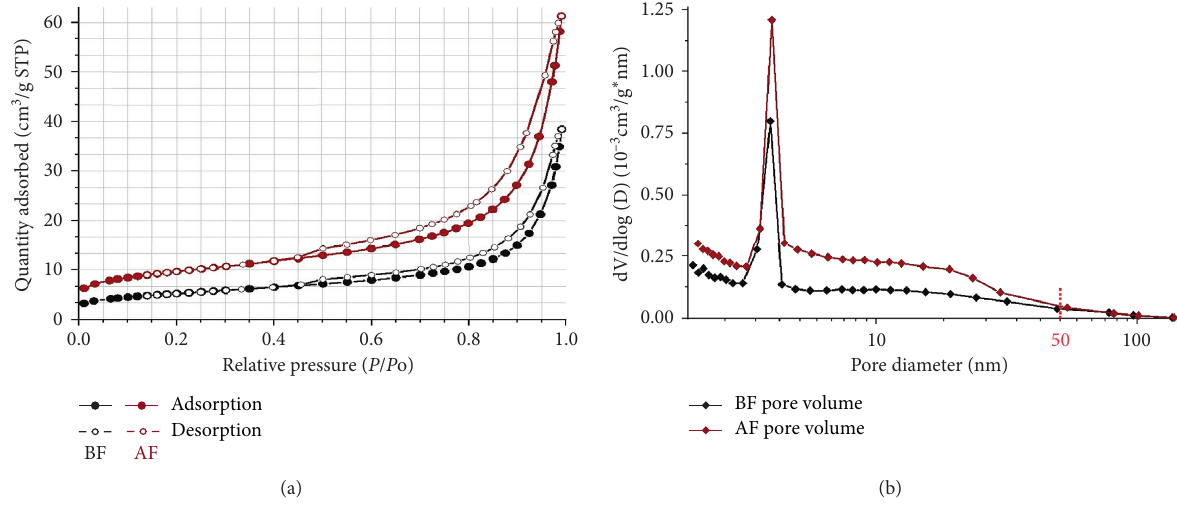
Figure 8: Curve of N 2 adsorption (77K) and pore diameter distribution of MT before and after freeze-thaw